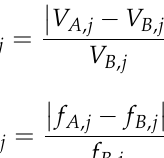
Figure 5. Multi-channel wearable heart sound visualization